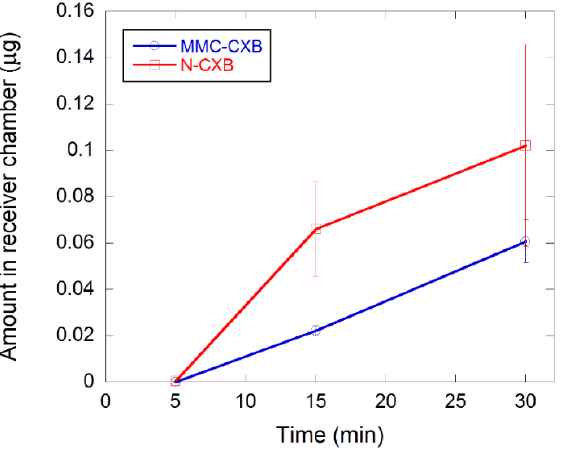
Figure 6. Transport of CXB from MMC and Neusilin across the Caco-2 membrane. The initial CXB concentration in both samples is 300 µ g. No detectable signal was observed for crystalline CXB. Data are presented as mean concentration with error bars representing standard deviations ( n =